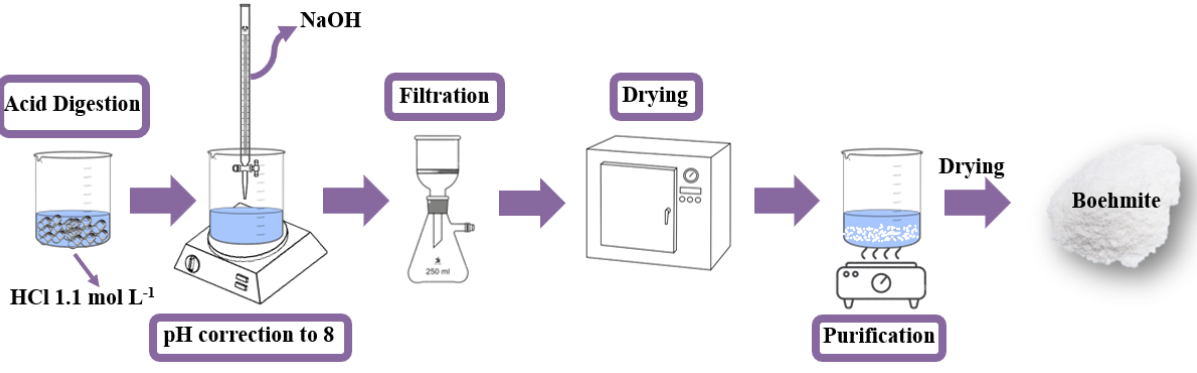
Figure 1. Schematic diagram of the synthesis route used to obtain the boehmite (γ -AlO(OH)).